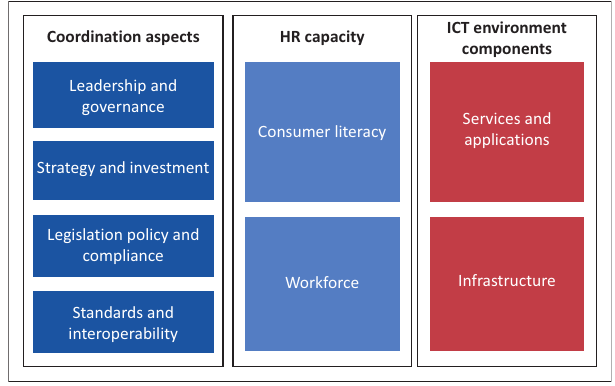
FIGURE 1: Summary of components of an eHealth strategy. Source: Adapted from World Health Organization (WHO), 2012, National eHealth strategy toolkit , viewed 10 February 2014, from https://extranet.who.int/iris/restricted/